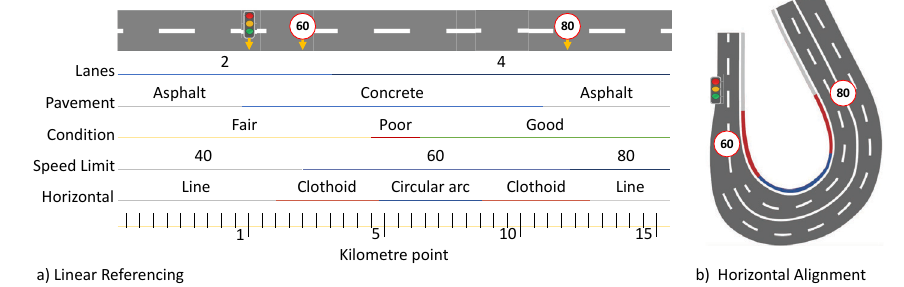
Figure 4. A linear referencing approach of a sample road is indicated in a) (Maryland, 2014), and b) shows the horizontal alignment illustration of the same road sample (Malmkvist et al.,